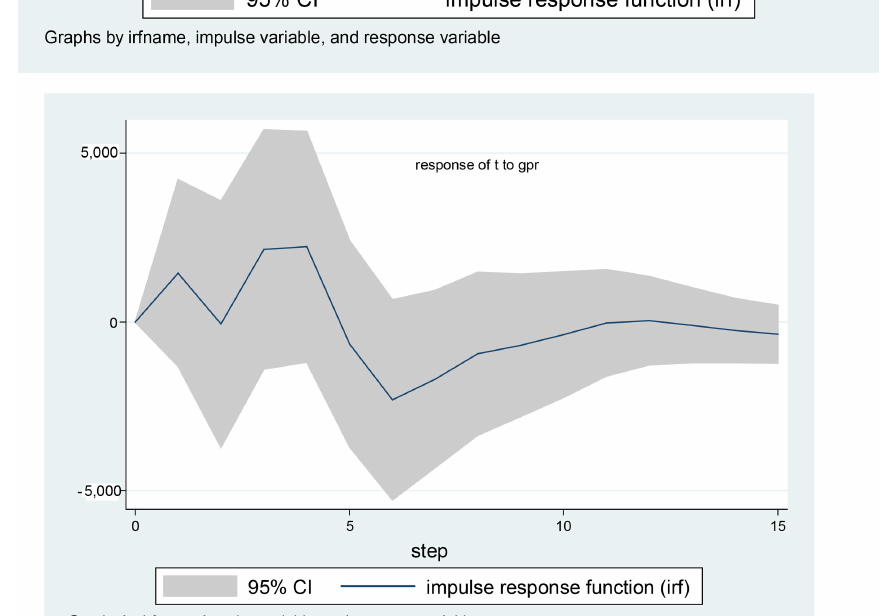
Figure 3. Impulse response of the